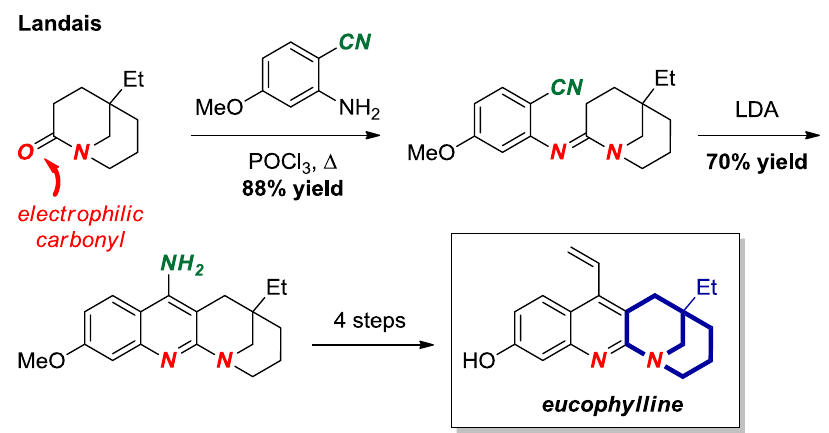
Figure 21. Bridged Amidine from a [3.3.1] Bridged Lactam in the Synthesis of Eucophylline.